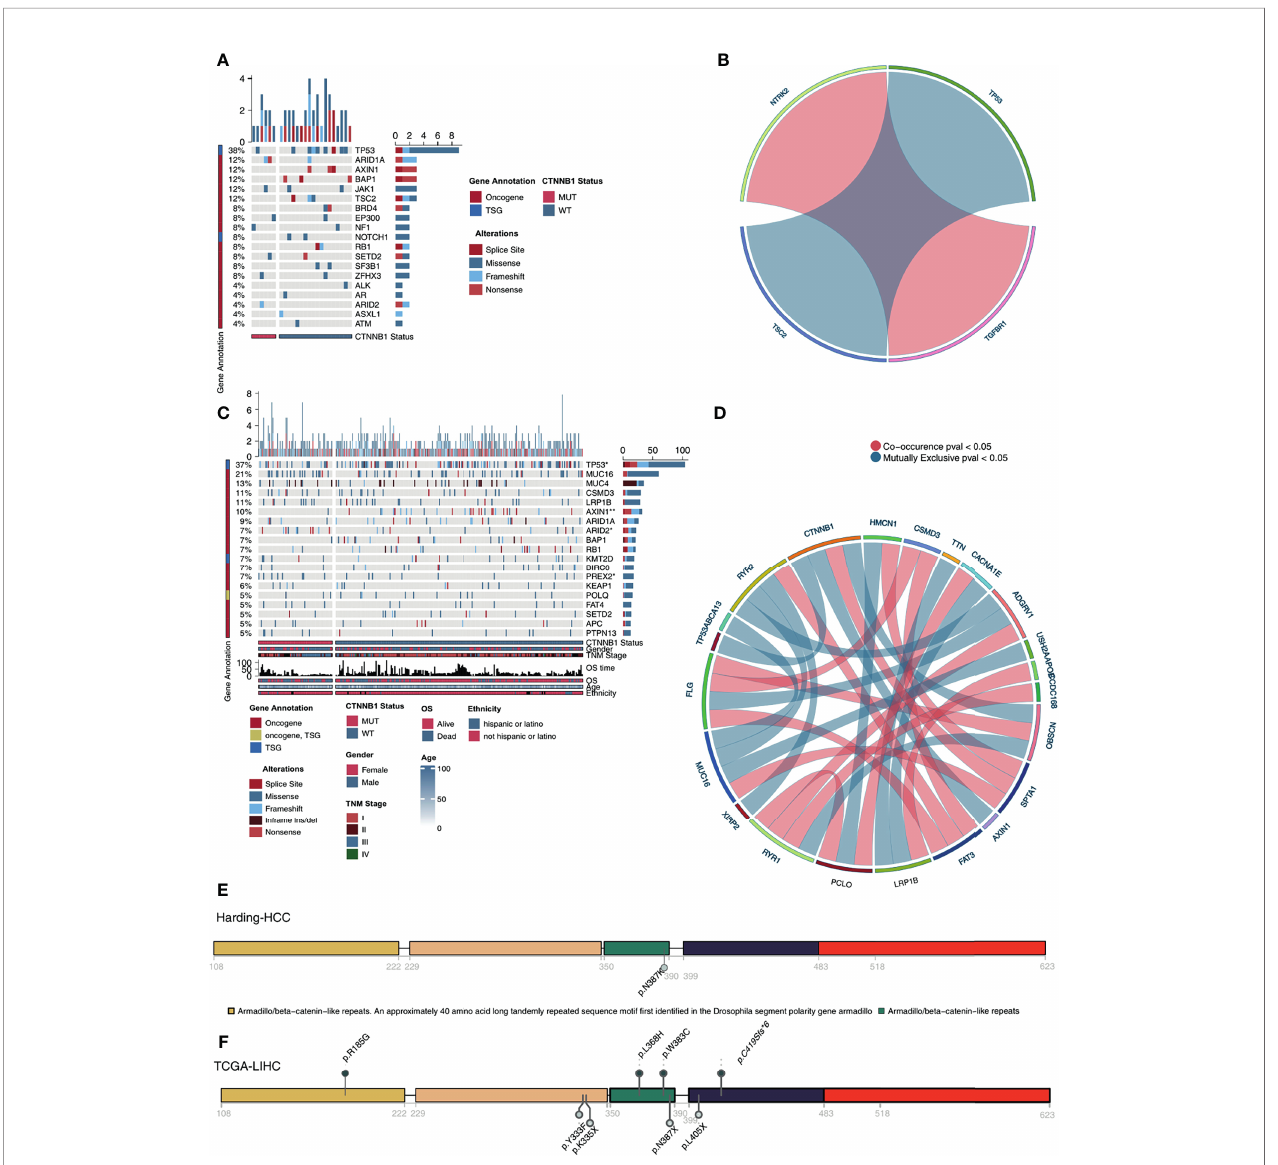
FIGURE 4 | Genomic pro fi les of HCC patients. (A) . The top 20 mutated driver genes in the Harding-HCC cohort. (B) . Ribbon plot showing the co-occurrence (or mutually exclusive relation) between pairs of mutated driver genes in the Harding-HCC cohort. (C) The top 20 mutated driver genes in the TCGA-LIHC cohort. (D) Ribbon plot showing the co-occurrence (or mutually exclusive relation) between pairs of mutated driver genes in the TCGA-LIHC cohort. Lollipop plot showing the distribution of CTNNB1 mutations in the Harding-HCC (E) and TCGA-LIHC (F) cohorts. *P < 0.05; **P <